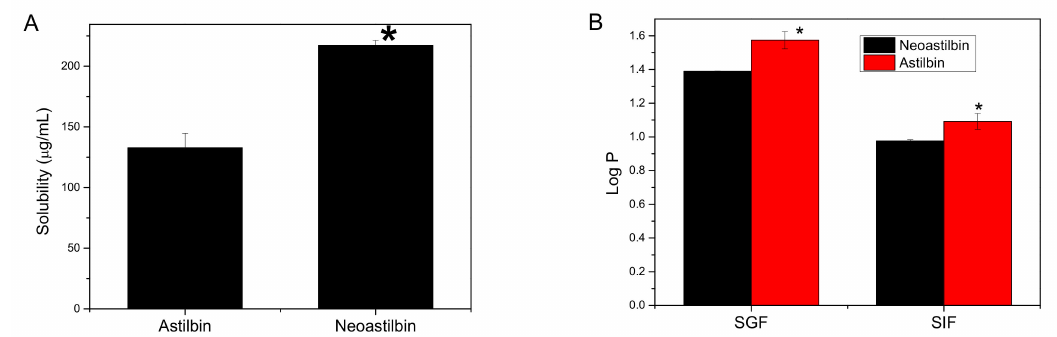
Figure 1. ( A ) The solubility of astilbin and neoastilbin in water at 25 ◦ C (n = 3). ( B ) The oil–water distribution (log P) of astilbin and neoastilbin in the simulated gastric fluid (SGF) and simulated intestinal fluid (SIF) at 37 ◦ C (n = 3). * means significant di ff erence between astilbin and neoastilbin ( p <